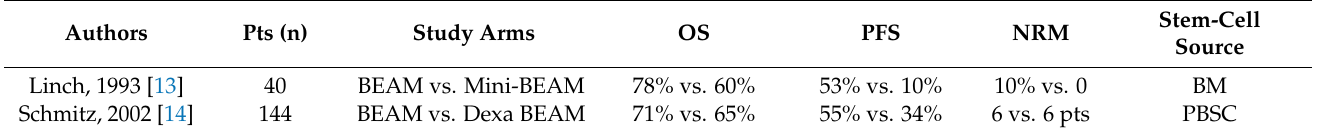
Table 1. Randomized studies of auto-HCT in